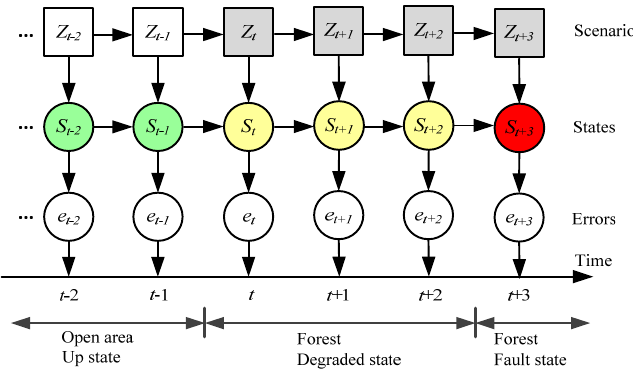
Figure 9. Test scenarios and transition.